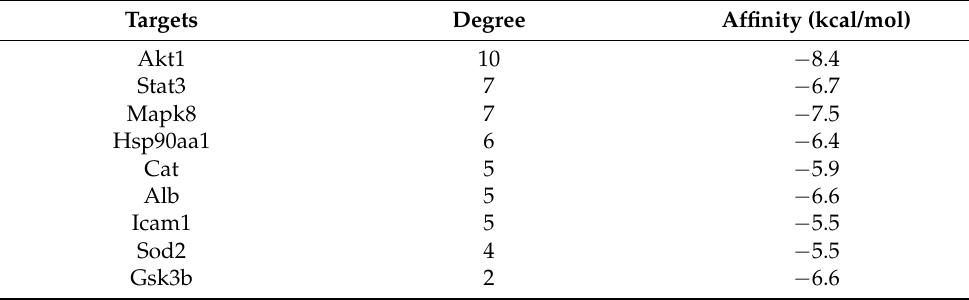
Figure 5. ( a ) Intersection of ROS candidate targets and constipation targets, and ( b ) PPI network visualization of overlapped targets, and the size of nodes represents the value of the degree. Table 1. PPI network topology analysis and corresponding binding